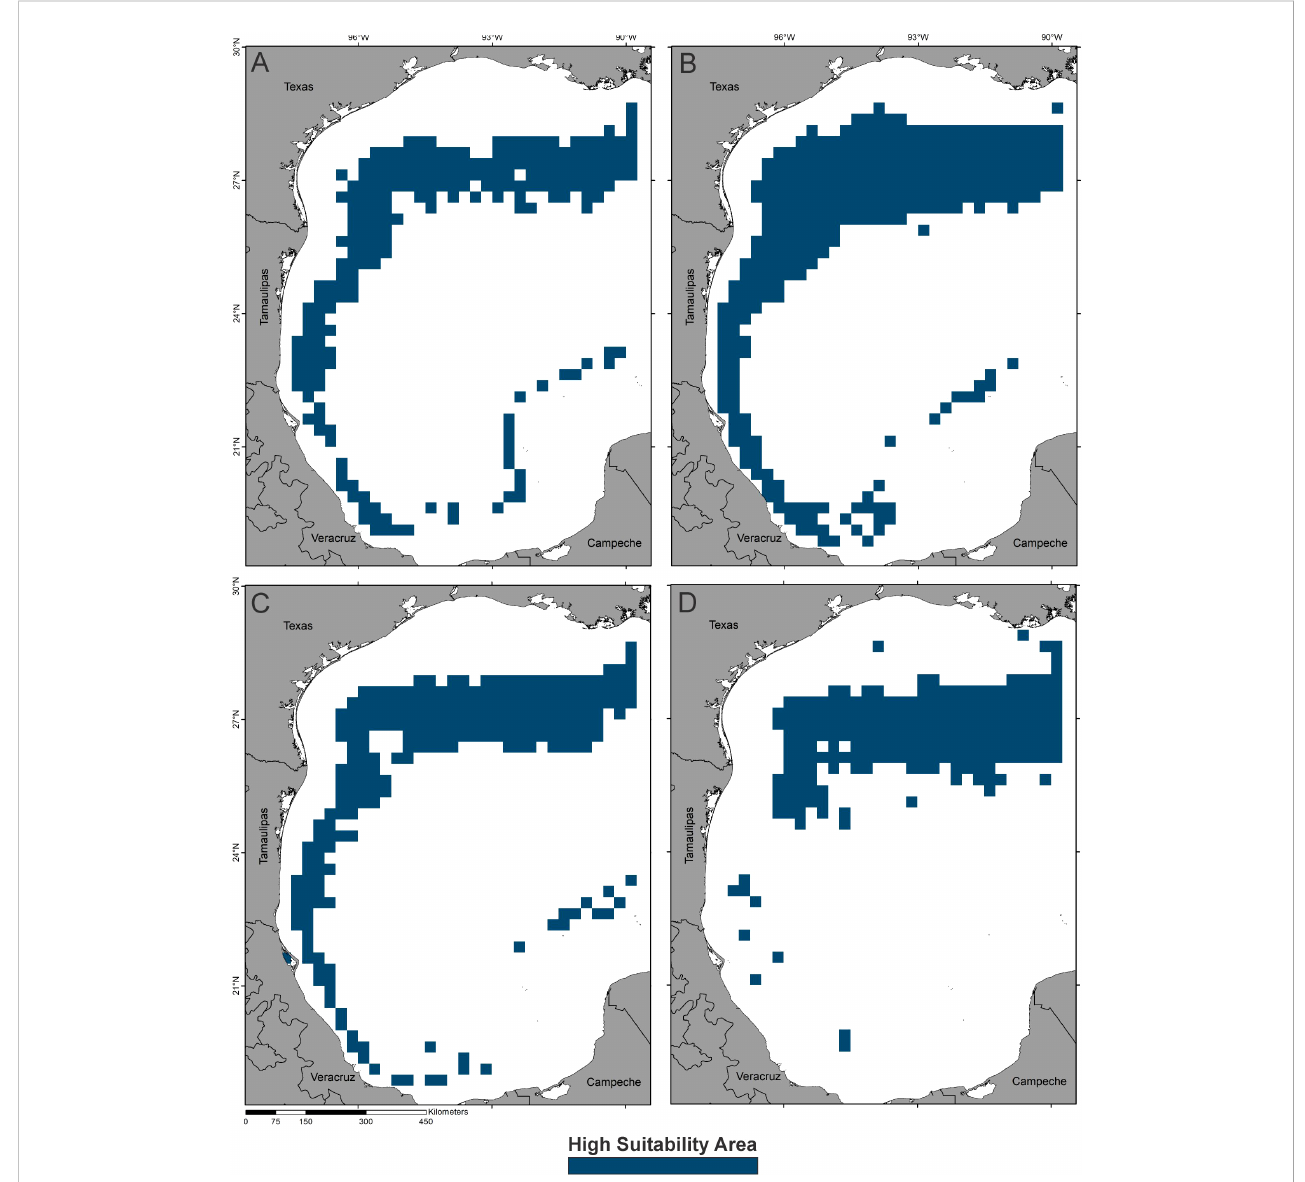
FIGURE 2 High suitability areas (in blue) in the western Gulf of Mexico for the sperm whale (A) , rough-toothed dolphin (B) , Risso ’ s dolphin (C) , and Clymene dolphin (D) . Based on Ram ı ́ rez-Leo ́ n et al.